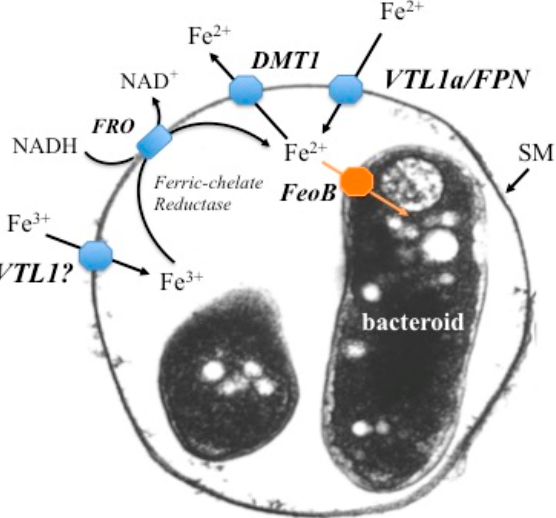
Figure 2. Schematic representation of proposed iron transport in a symbiosome. A symbiosome membrane (SM) surrounding two bacteroids is shown. Ferrous iron is transported across the sym- biosome membrane via two avenues: VTL1a (Vacuolar iron Transporter Like protein) in soybean and M. truncatula and FPN (ferroportin) in M. truncatula . Ferric iron is also transported into the symbiosome, but the protein responsible has not been identified. The symbiosome space is a stor- age compartment for iron, in much the same manner as a vacuole. Ferric iron in the symbiosome space can be reduced by a ferric chelate reductase (FRO) on the SM and transported either into the bacteroid via the freoB transporter or back into the infected cell’s cytosol via DMT1 (Divalent Metal Transporter). See text for more details.